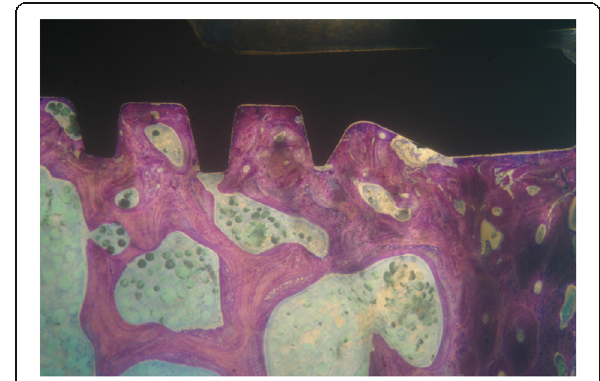
Figure 4 Control group. No bone condensation was possible with traditional burs and standard implant (magnification × 25 — toluidine blue)